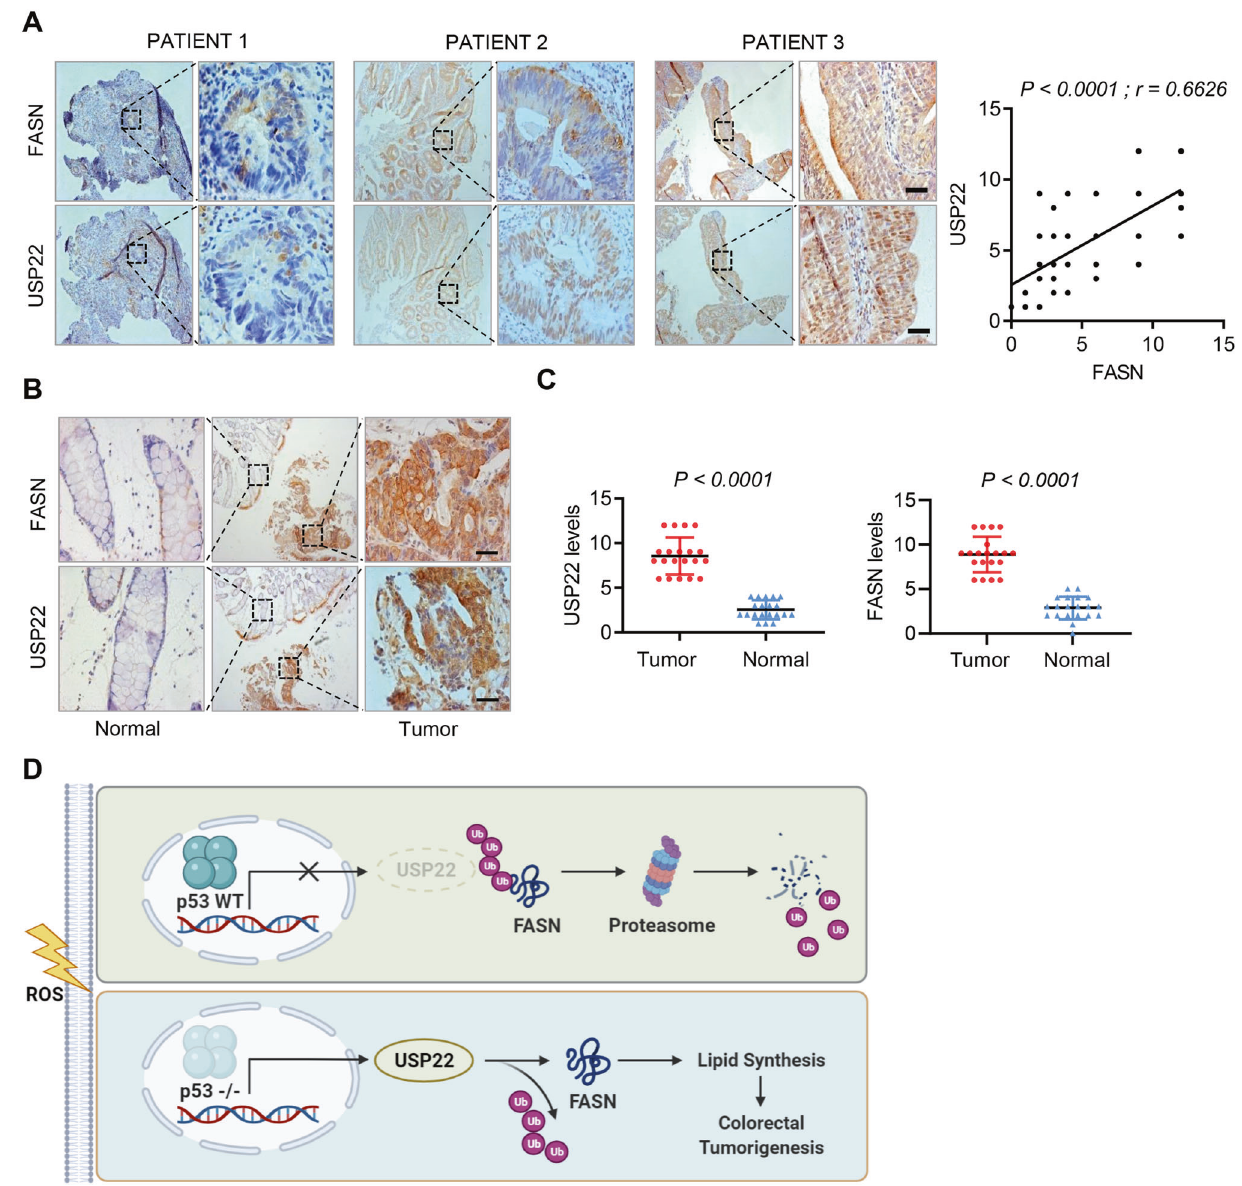
Fig. 7 FASN is positively correlated with USP22 expression in colorectal cancer. A Immunostaining of USP22 and FASN in human CRC specimens. Representative images of three tumors are shown. Insets: high-magni fi cation images corresponding to the areas marked by black dotted lines. Scale bars, 100 µm. Staining of USP22 and FASN was scored on a scale of 1 – 12. The correlation between USP22 and FASN was statistically signi fi cant among different specimens ( n = 108 colorectal tumors, top panel, r = 0.6626, P < 0.001). Note that the scores of some samples overlap (right panel). B , C Human CRC tissues and the paired paracancerous non-tumor tissues were immunostained with anti-USP22 and anti-FASN antibodies, respectively. Representative images of the immunostaining were shown ( B ). Scale bars, 200 µm. The expression scores of USP22 and FASN were compared in the tumor and non-tumor tissues ( n = 20 CRC tissues, paired Student ’ s t-test). D Diagram shows the fi ndings revealed in this study. In p53 wild-type CRCs, ROS-induced p53 expression represses the transcription of USP22, which otherwise deubiquitinates and stabilizes FASN, and thus inhibits FA synthesis and tumor growth. In p53-de fi cent tumors, ROS-mediated inhibition of USP22 is relieved, leading to FASN stabilization, which thus promotes lipid synthesis and tumorigenesis.